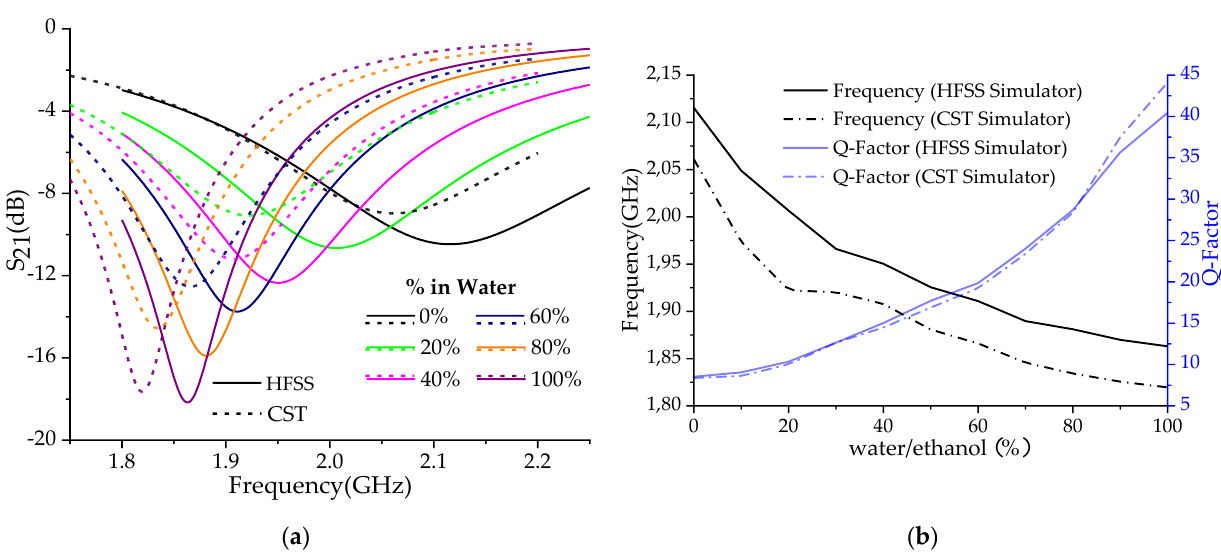
Figure 11. Simulated results: ( a ) S 21 response and ( b ) resonant frequency and Q factor for different mixture water concentrations, with r = 2.5 mm.